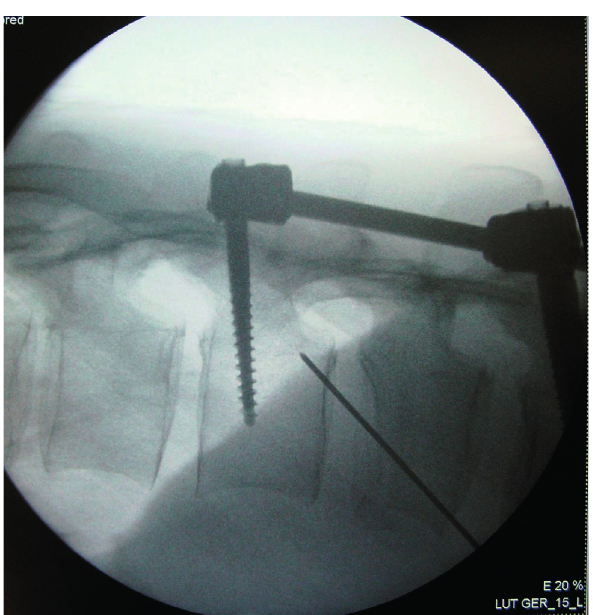
Fig. 1. K-wire is placed under fluoroscopic control on the skin to determine place of incision.